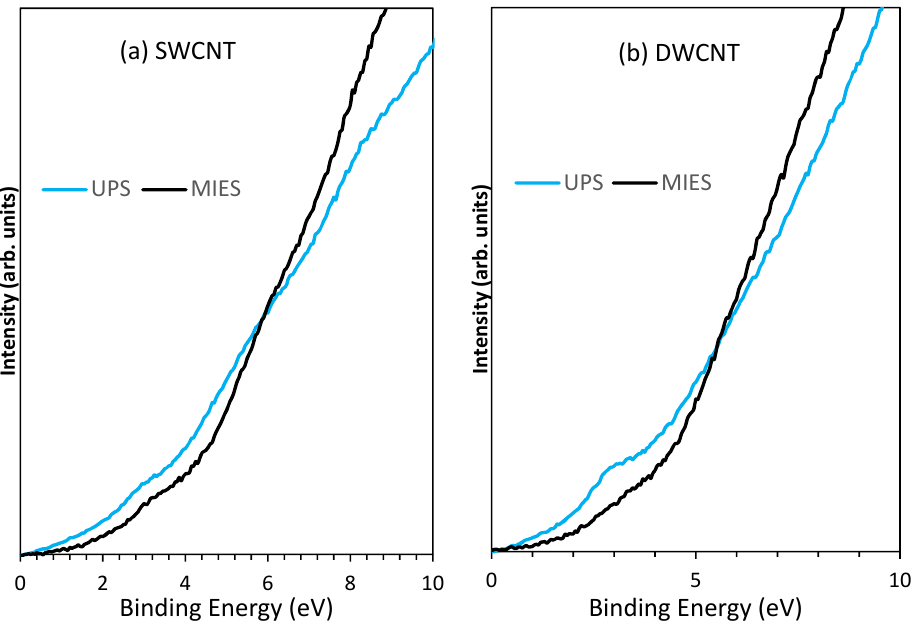
Figure 2. Comparison of ultraviolet photoelectron (UP) and metastable helium induced electron (MIE) spectra at low temperatures for both ( a ) SWCNT (113 K) and ( b ) DWCNT (173 K).